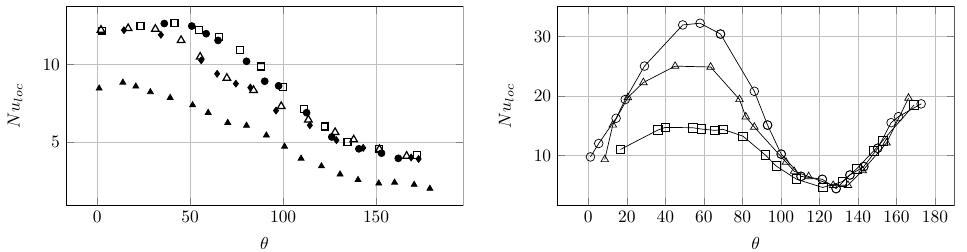
Figure 10. Left : Local nusselt number for a uniform flow past an isolated sphere at Re = 50 ( ) and for a uniform flow past a FCC array of spheres at Re = 50, α d = 0.15: β = 0 (( ) Massol [10], ( ) present work ) and β = 45 (( ) Massol [10], ( ) present work ). Right : Local Nusselt number for a uniform flow past a FCC array of spheres at Re = 300, α d = 0.15: β = 0 ( ), β = 22.5 ( ), β = 45 (